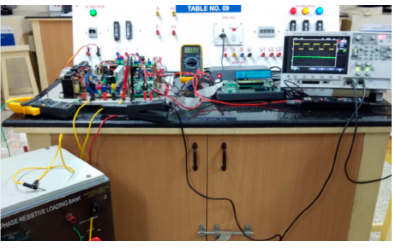
Figure 13. Hardware setup.